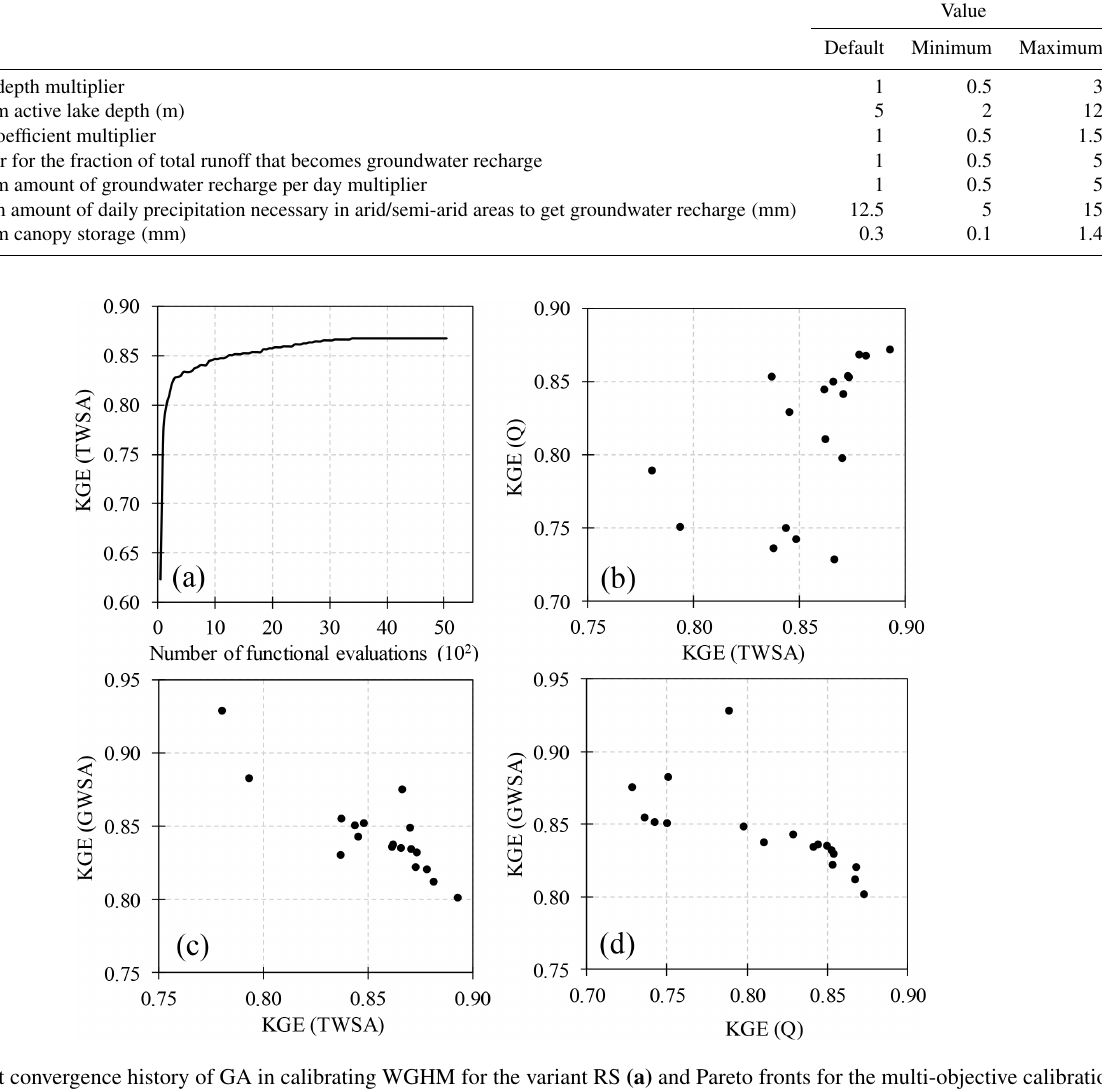
Table 1. WGHM parameters with the most effect on TWSA, inflow into the lake, and groundwater storage. Parameter